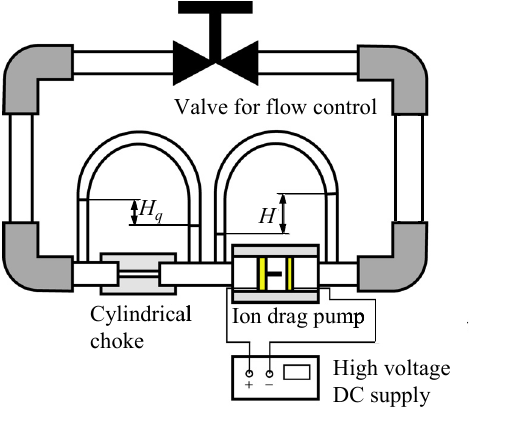
Fig.1 Cross-sectional views of ion drag pumps (not to scale)